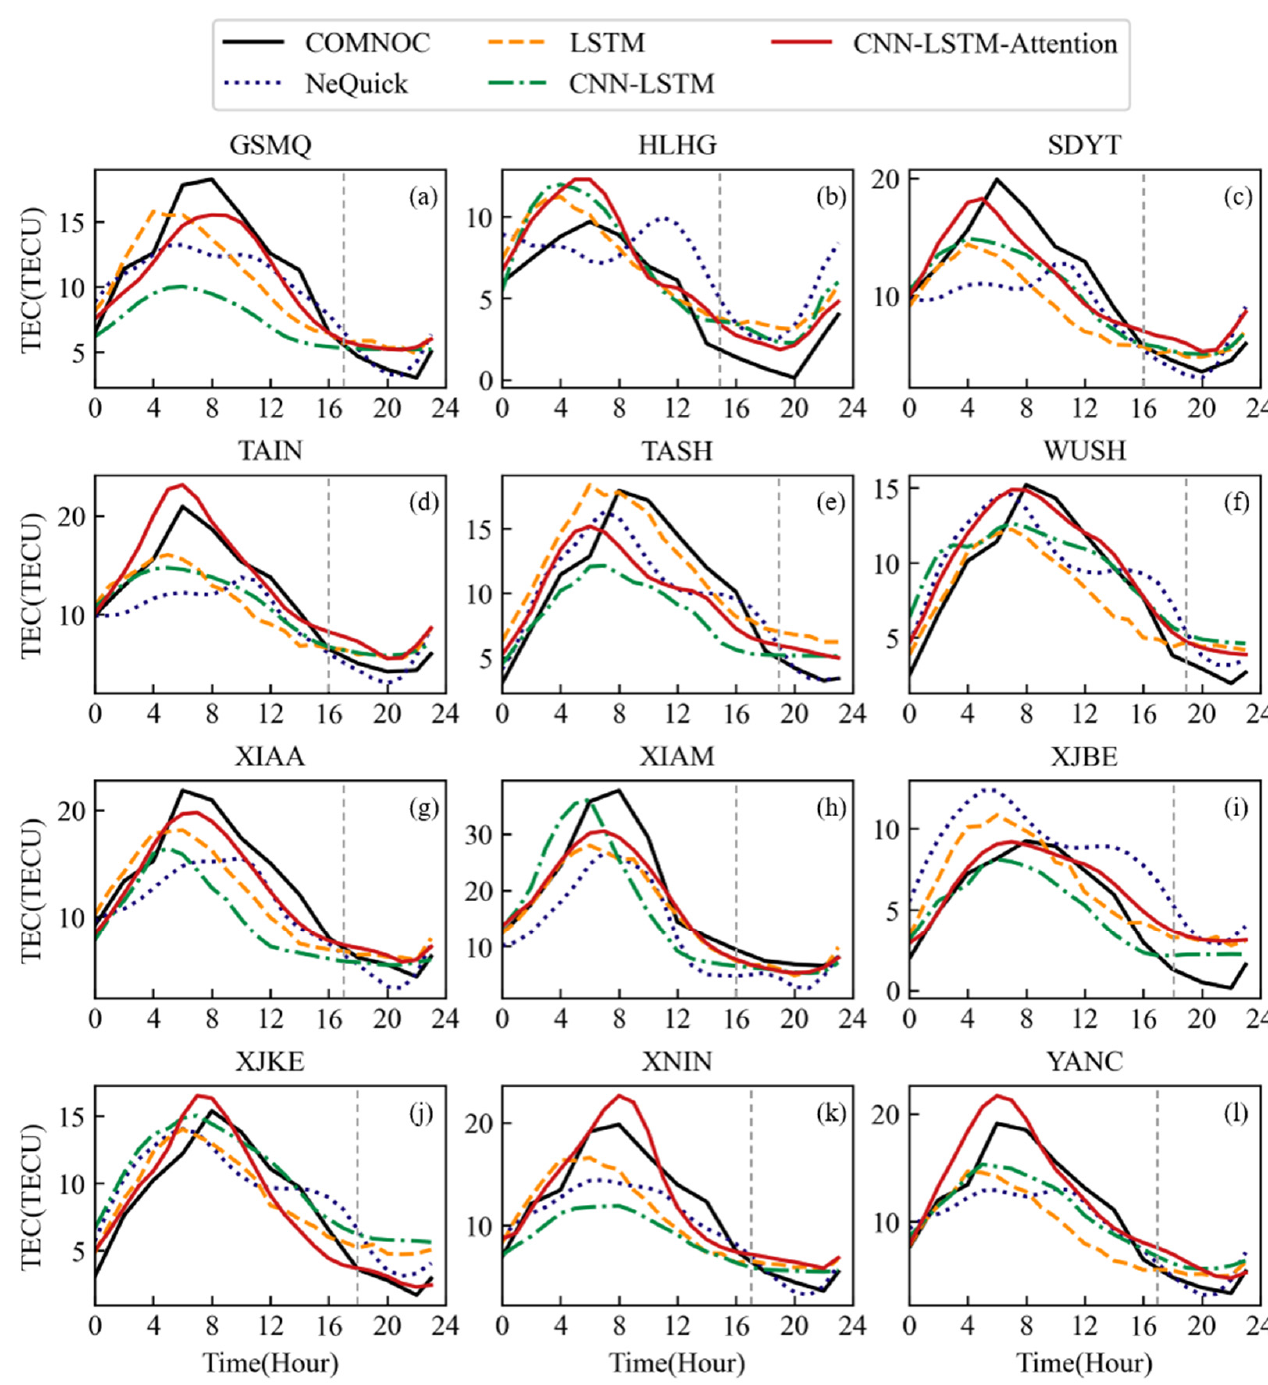
Figure A4. ( a – l ) Comparison of GNSS measured values (black solid line), NeQuick (blue dotted line), LSTM (yellow dotted line), CNN-LSTM (green dotted line), and CNN-LSTM-Attention (red solid line) models forecasted values for other 12 GNSS stations on magnetic storm day. The gray dotted line indicates midnight LT.